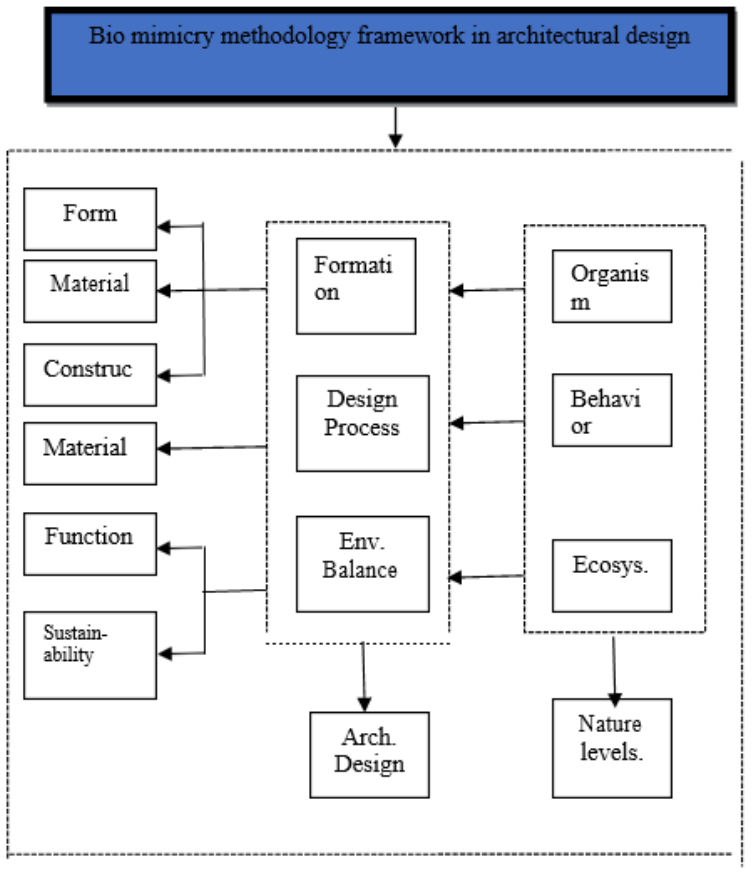
Figure 6. Shows the bio mimic methodology framework in architectural design. Source: the writer